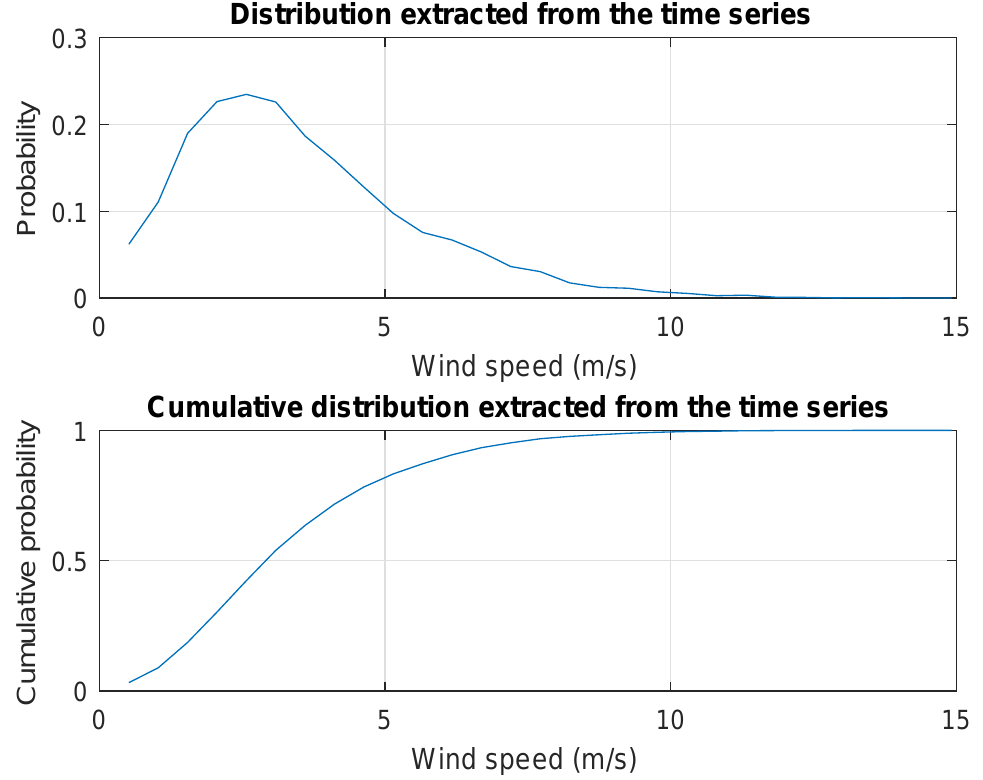
Figure 22. The portraits of distribution and cumulative distribution extracted from the time series in OSWFs in Yangshan port, Shanghai from 22 August 2017 to 22 August